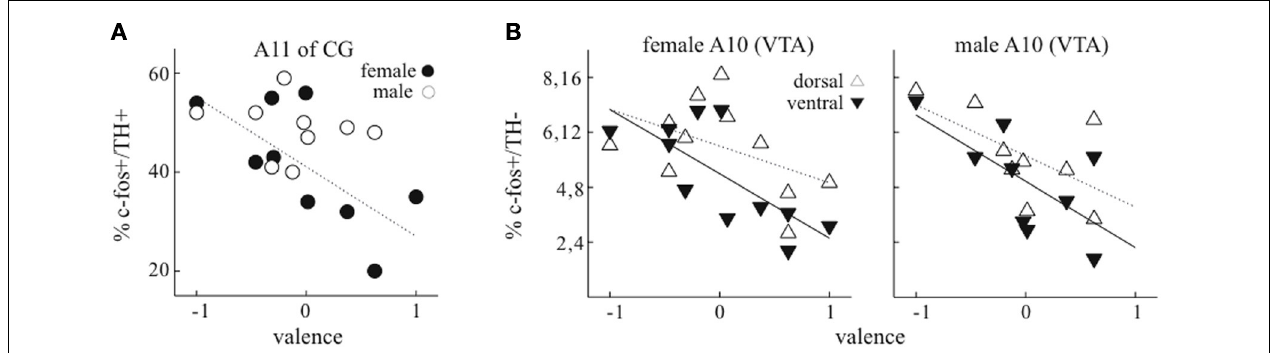
FIGURE 4 | Relationship of pair valence to expression of c-Fos in dopaminergic and non-dopaminergic neurons. (A) In dopaminergic neurons in central gray (CG/PAG), the level of expression of c-Fos was negatively correlated with valence in females (filled symbols) but not males (empty symbols). Dotted lines represent linear fit to female data. (B) In non-dopaminergic neurons in VTA, for females